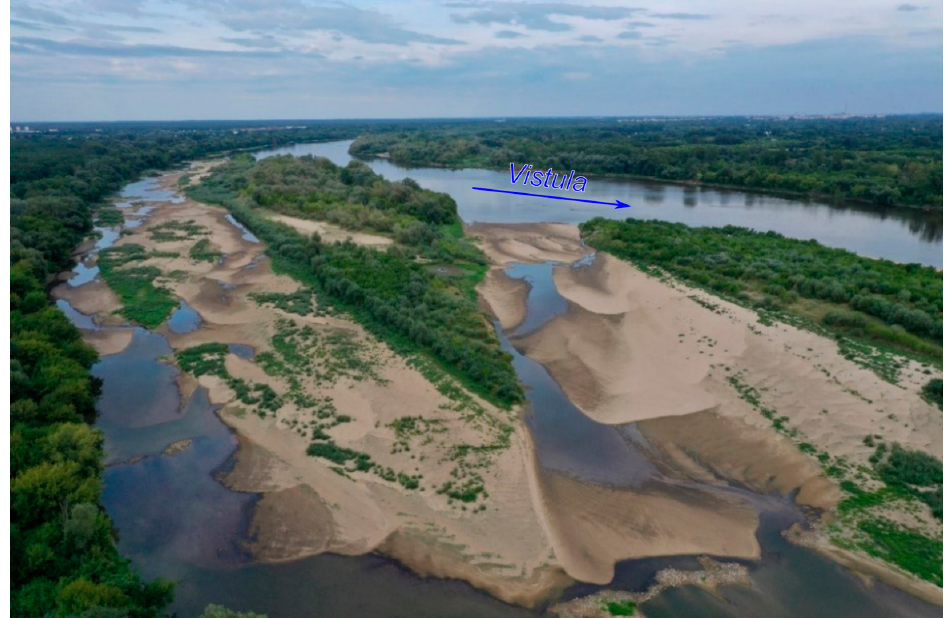
Figure 2. Study area within the “ Ł awice Kie ł pi ń skie” reserve. Oblique photo taken from a UAV in July 2019 showing a panoramic view upstream, towards Warsaw: northern part located in the Jab ł onna commune. Exposed sandbars and islands with varying levels of vegetation can be seen.